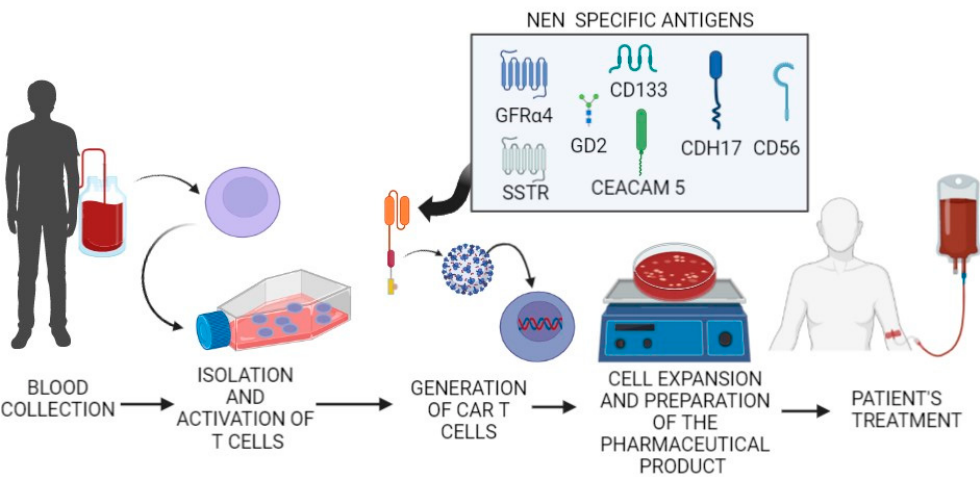
Figure 2. The process of developing CAR-T cells as a therapeutic approach for NEN.